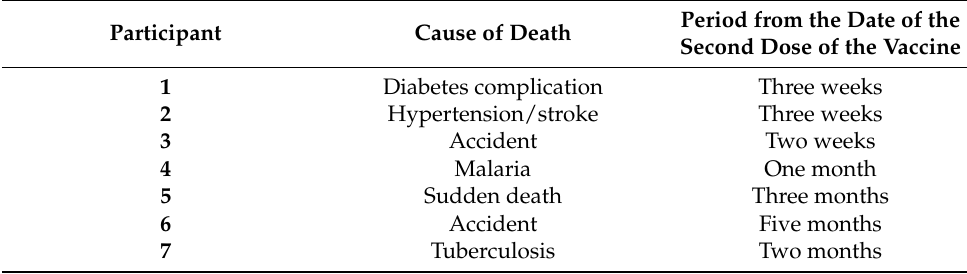
Table 4. Deaths following receipt of Oxford/AstraZeneca